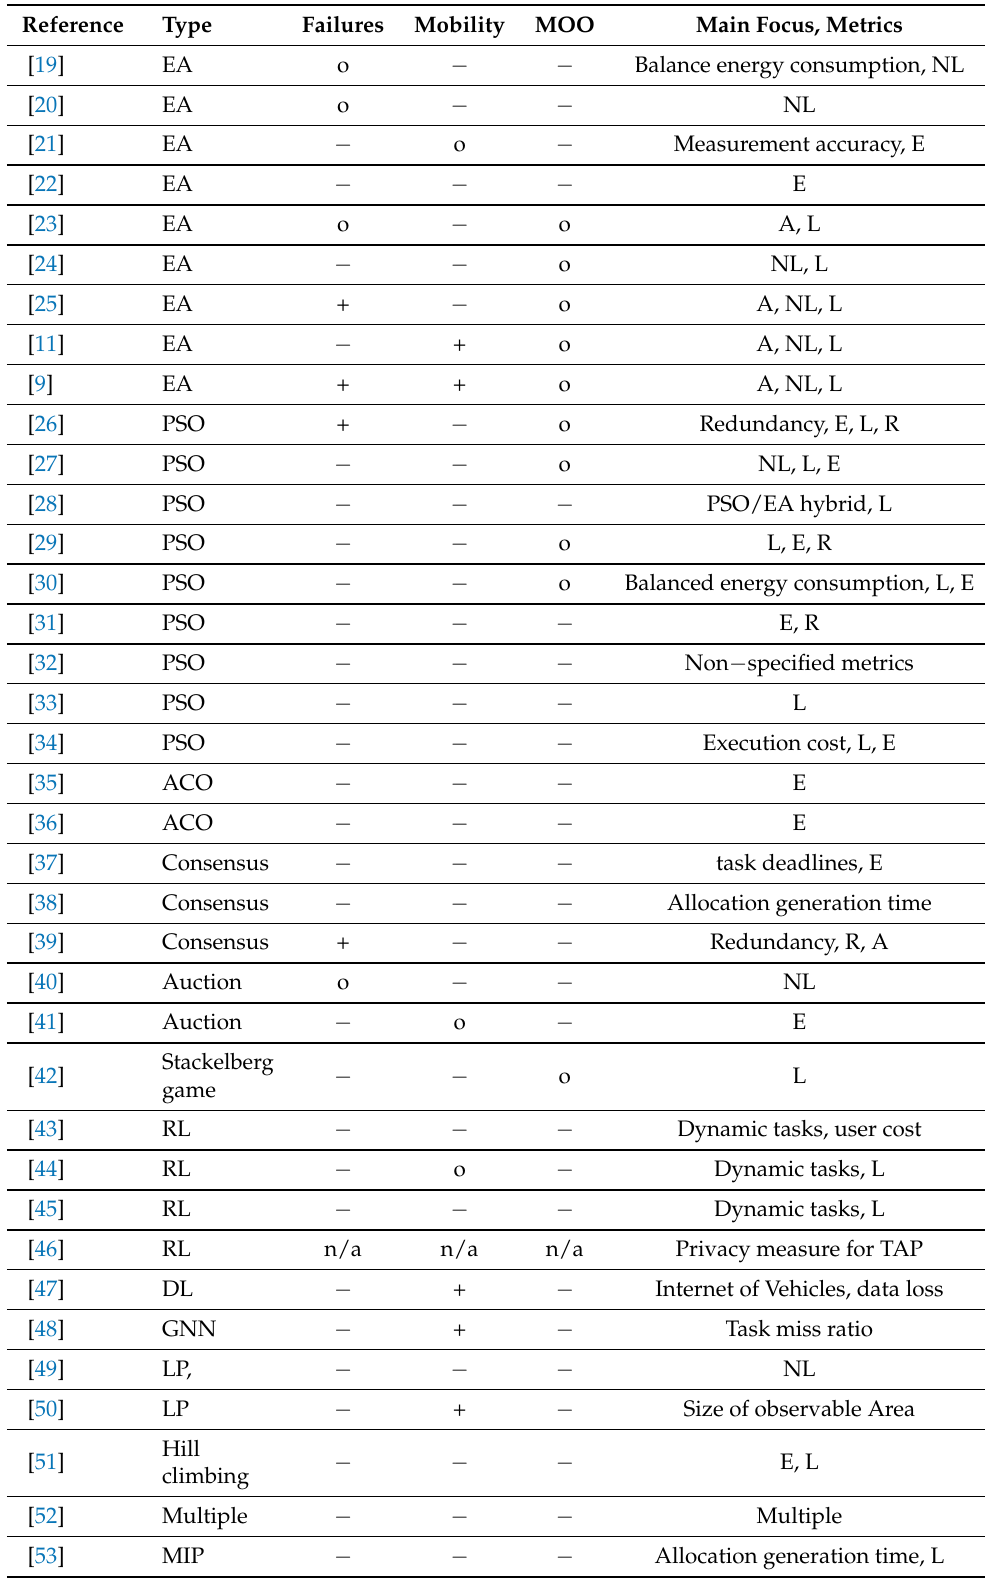
Table 2. Overview of state-of-the-art